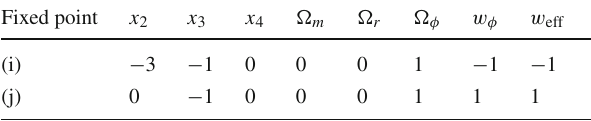
Table 3 The fixed points, the density parameters, and the equation of state parameters of the Cuscuta–Galileon without a potential Fixed